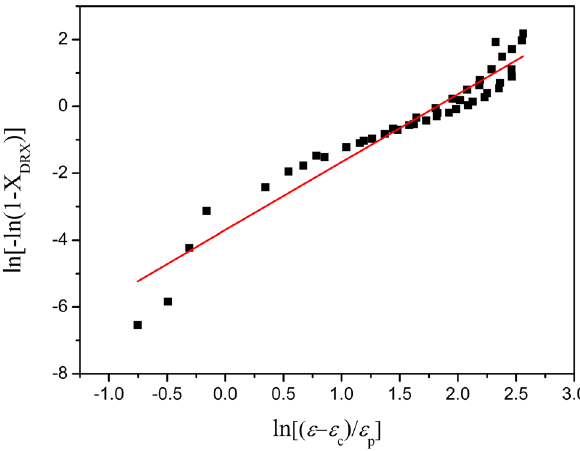
Figure 11: Relationship between [